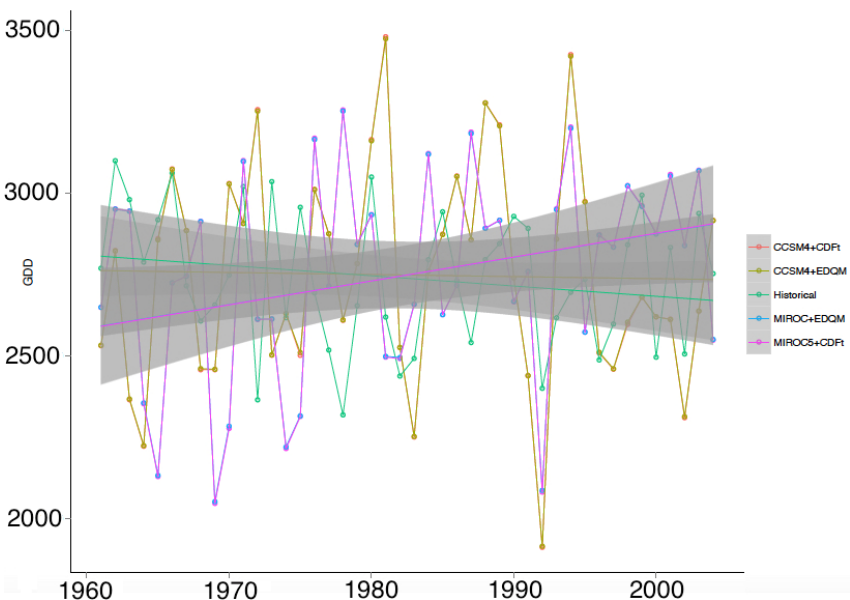
Figure 5. Annual variability between the GDD from the observed historical dataset and the downscaled historical time series.